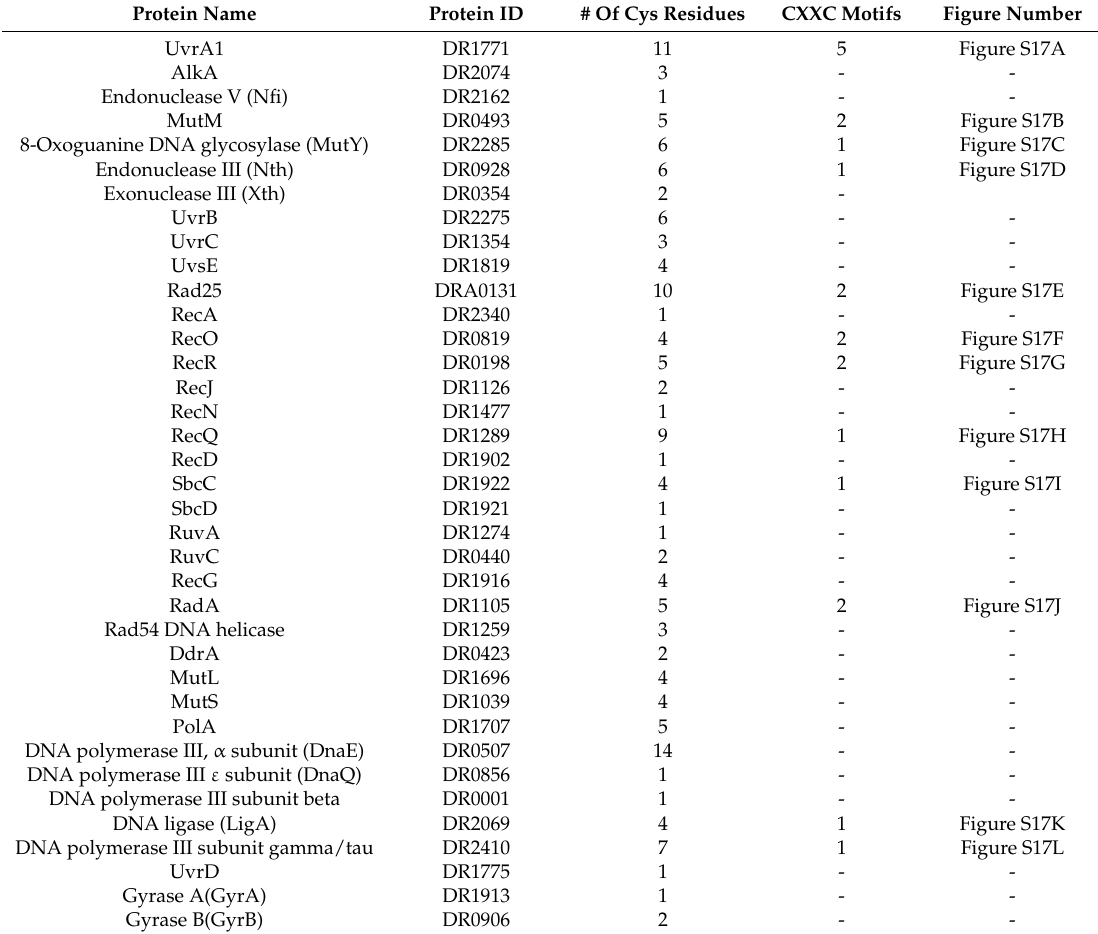
Table A1. Presence of Cysteine Residues and CXXC Motifs in DNA Repair